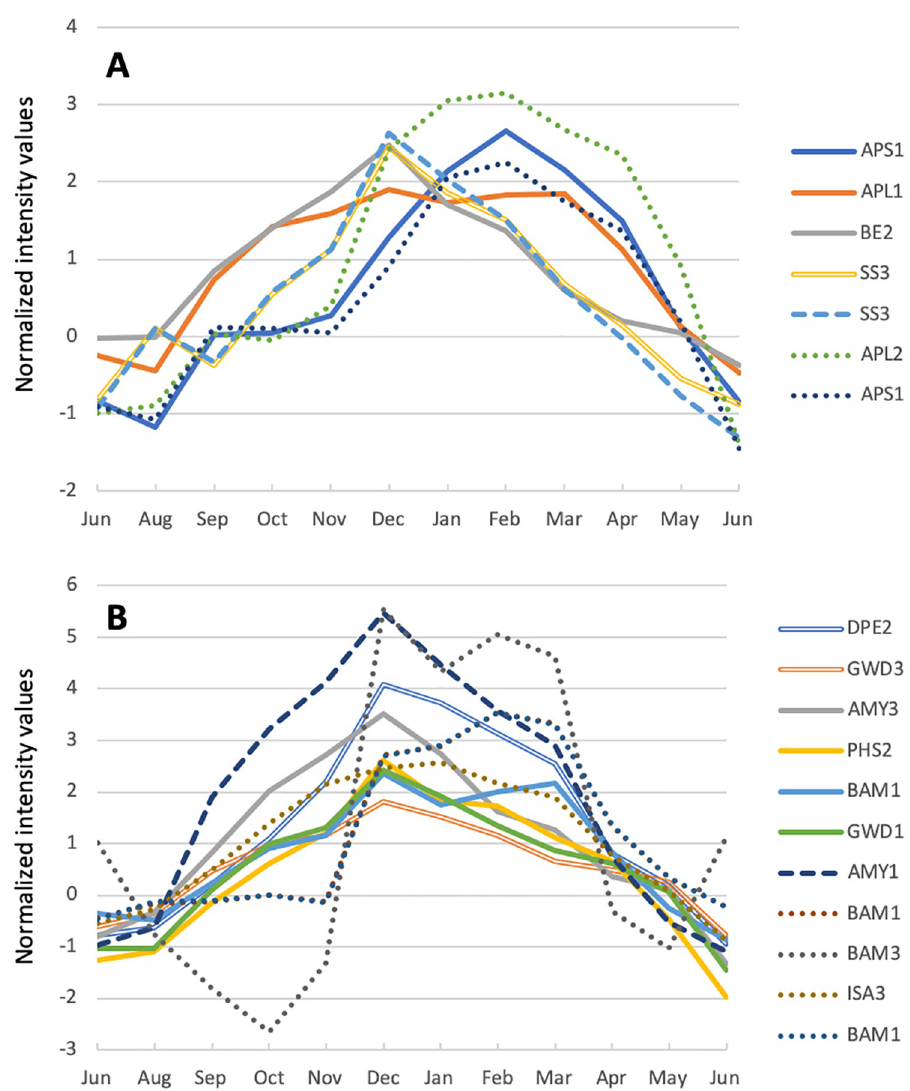
Fig 6. Annual expression patterns of starch-related genes. Each line represents the average normalized intensity value of an individual transcript of a gene involved in starch synthesis (A) or starch degradation (B), as listed in Table 5. Broken lines and solid lines indicate transcripts up-regulated by SD and LT conditions, respectively. Double lines indicate transcripts up-regulated by both SD and LT conditions. Dotted lines indicate transcripts not up- regulated by either SD or LT conditions in this